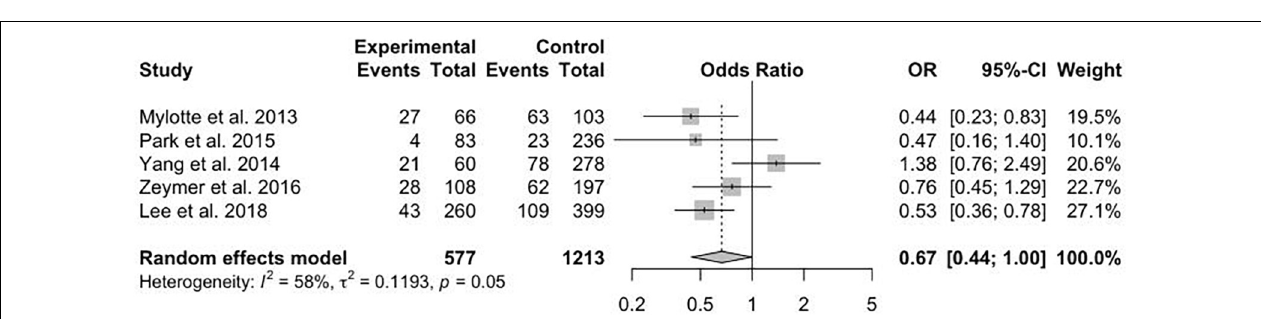
FIGURE 3 | Long-term mortality with multivessel (MV) vs. culprit vessel-only (CO) percutaneous coronary intervention (PCI) in patients with ST-segment elevation myocardial infarction (STEMI) complicated by cardiogenic shock (CS).